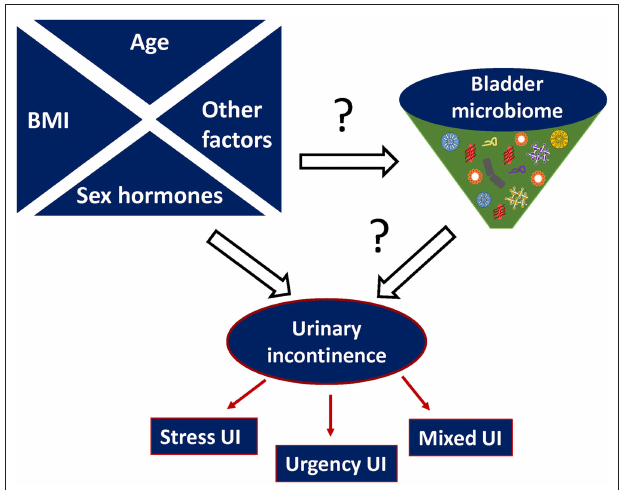
FIGURE 2 | Proposed relationship between urinary microbiome and urinary incontinence (UI). Other possible risk factors that can affect both microbiome imbalance and urinary incontinence include (but are not limited to) hereditary predisposition, metabolic diseases e.g., diabetes, parity